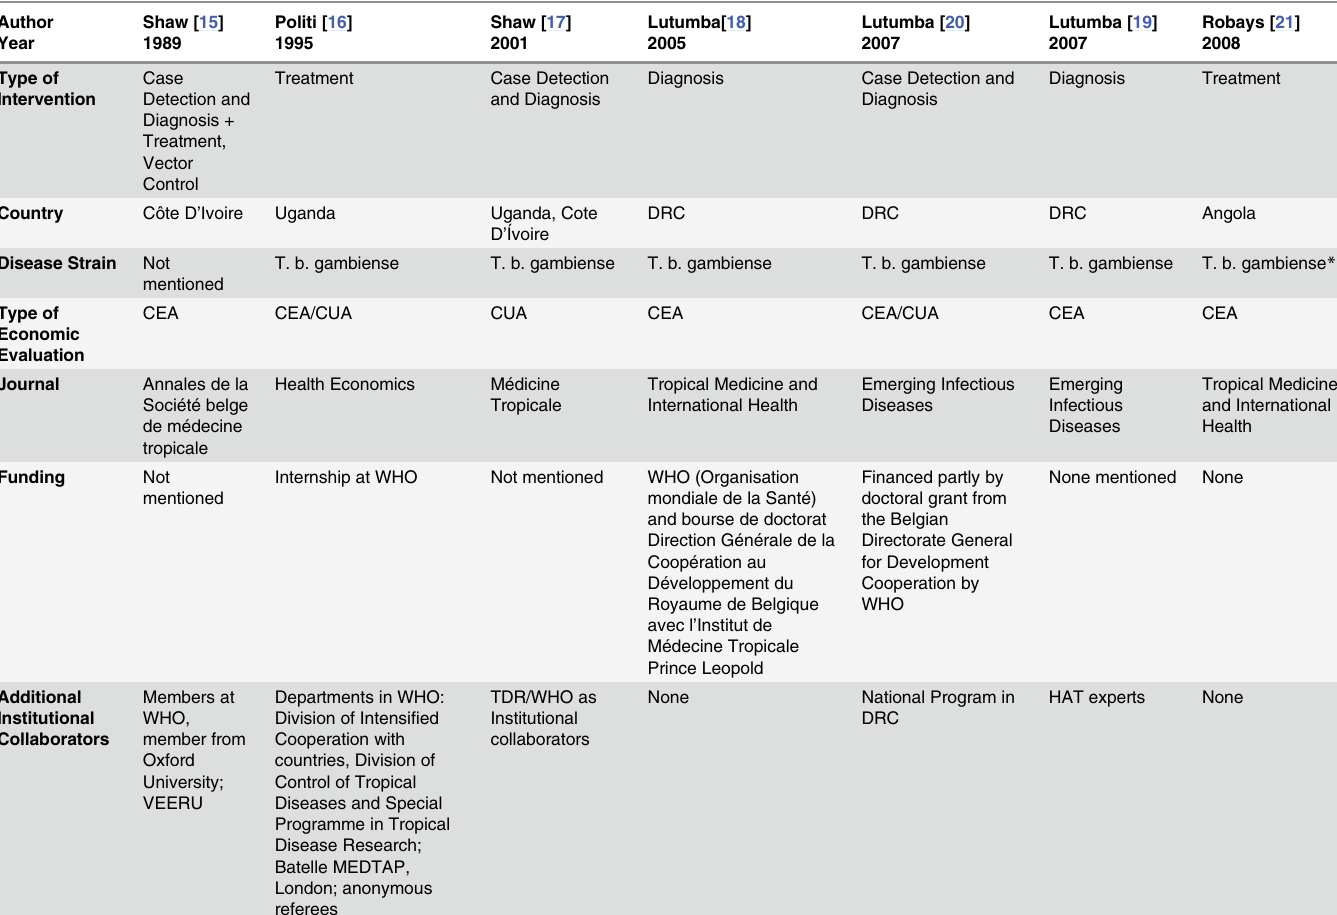
Table 3. Characteristics of included economic